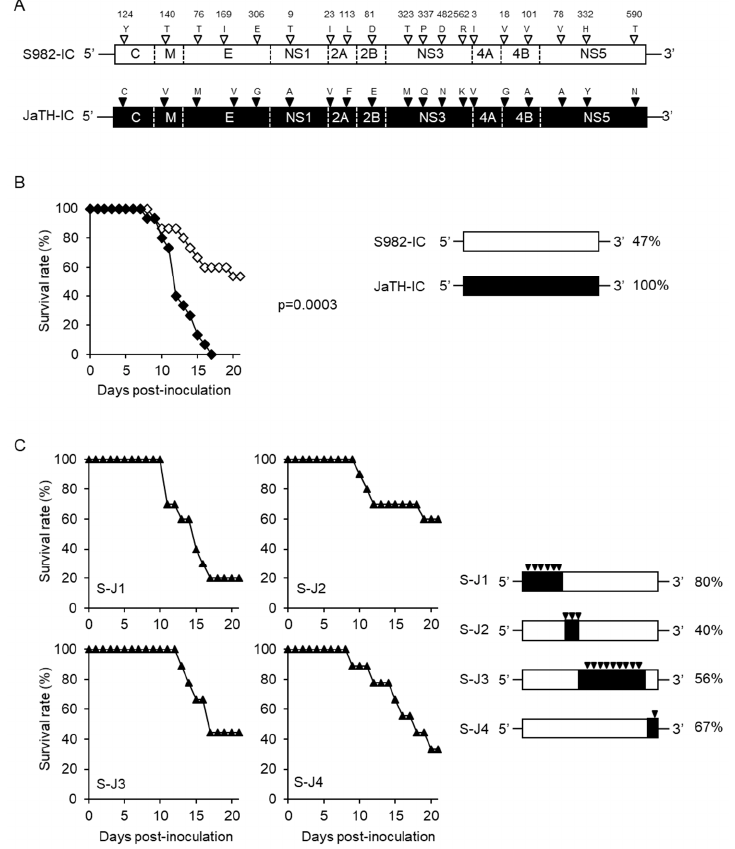
Figure 1. Mortalities of mice infected with recombinant viruses of JaOArS982 and JaTH160 replacing four distinct regions of the viral genome. ( A ) schematic representation of 19 amino acid differences